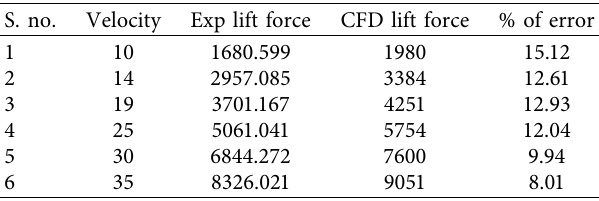
Table 8: Validation of the NASA SC(2)-0714 rotor. S. no.